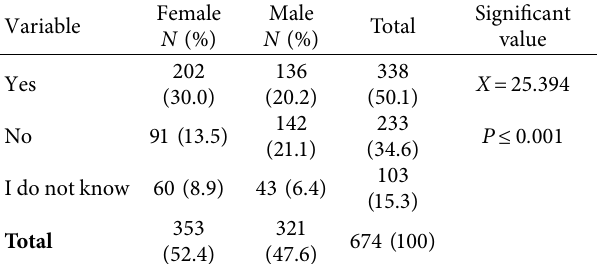
Table 7: Action taken to adapt to climate change.